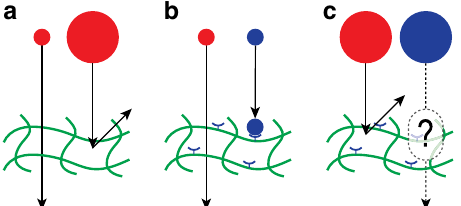
Fig. 1 Three strategies for fi ltering particles through a polymer hydrogel. a From simple steric interactions, particles that are smaller than the mesh size of the gel are able to diffuse through the gel, while larger particles are retained. b While generic small particles diffuse through the gel, speci fi c binding sites on the gel can slow down or trap non-generic particles that they bind to. This provides a simple mechanism to fi lter between equivalently sized small particles. c Since generic large particles do not diffuse through a gel, in order for a binding-based mechanism to successfully fi lter between equivalently sized large particles, binding must lead to enhanced mobility. How is this